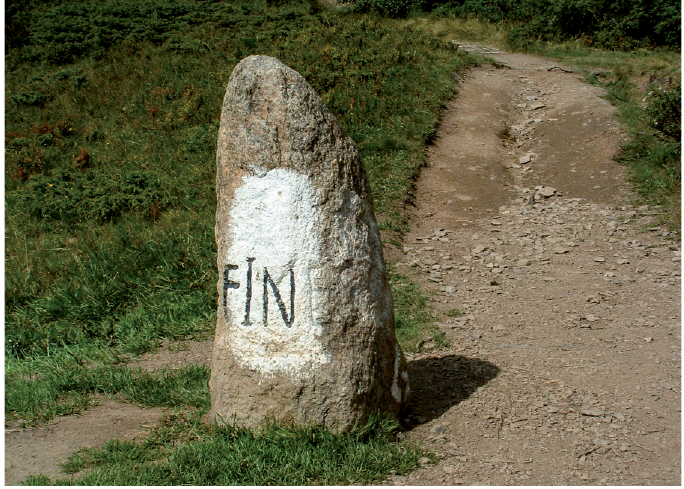
Figure 22. The boundary landmark ( Fines ) between the Ceutrons and the Allobroges territories at Le Jaillet pass (Haute- Savoie/French Alps), which is also on the communal limits between Le Cordon and La Giettaz. © Association La Giettaz et son